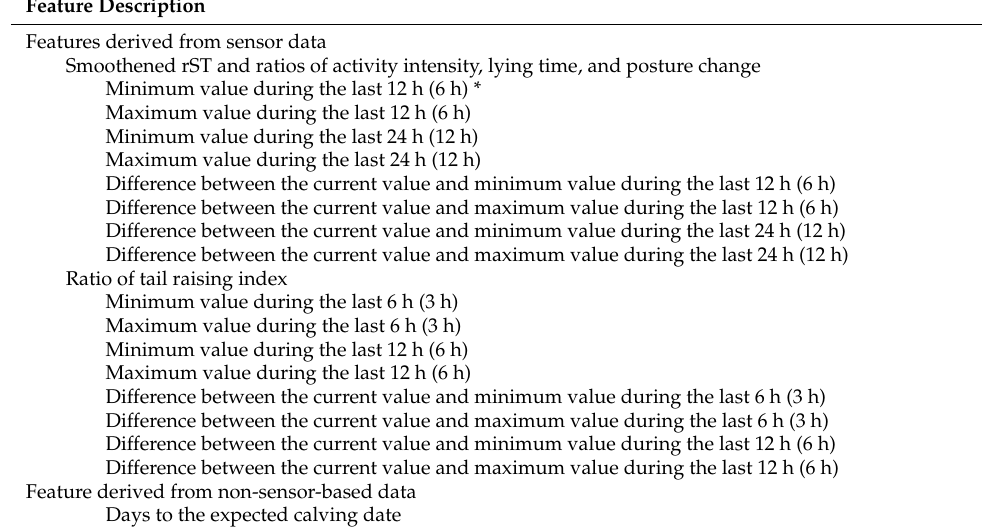
Table 1. Description of features used to build the calving prediction models for predicting 24-h and 6-h periods before calving through supervised machine learning. Feature